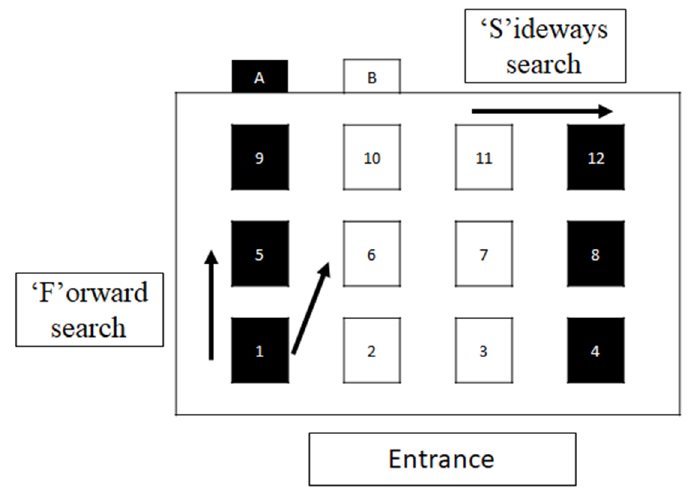
Figure 4. Well numbers assigned on the poke box. A parrot’s movement on the poke box can be categorised into two types: moving forward (e.g., 1 → 5 or 6) or moving sideways (e.g., 11 → 12). Depending on the pattern (A or B), the search order also provides correct and incorrect responses as well as the total number of wells opened for each trial.